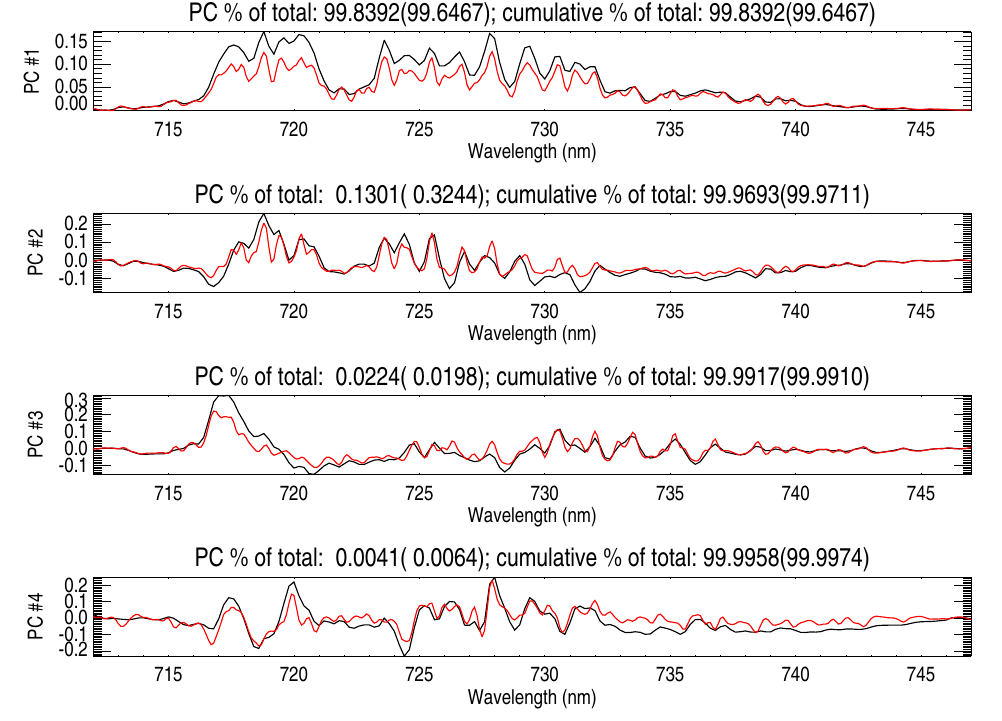
Fig. 5. Leading principal components (PCs) of simulated reflectance spectra for the short-wavelength fitting window for a GOME-like instrument with FWHM = 0.5nm (black) and a higher-spectral-resolution instrument with FWHM = 0.3nm (red); numbers in the top title are the variance explained in terms of percent of the total and cumulative percent of the total with numbers for FWHM = 0.3nm in parentheses.